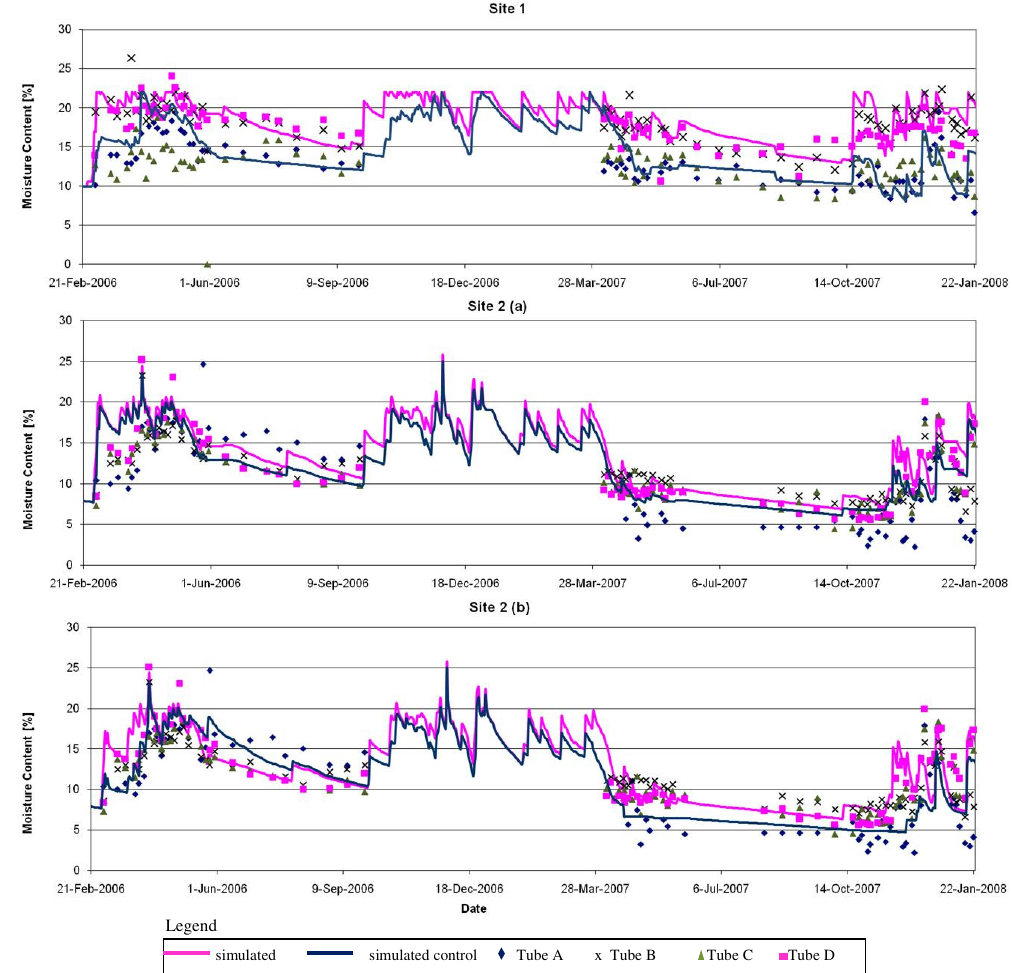
Figure 4: Model results at different sites compared with observed soil moisture values for Site 1 and Site 2. The graph at Site 2 (b) presents an improved simulation than the graph at Site 2 (a)